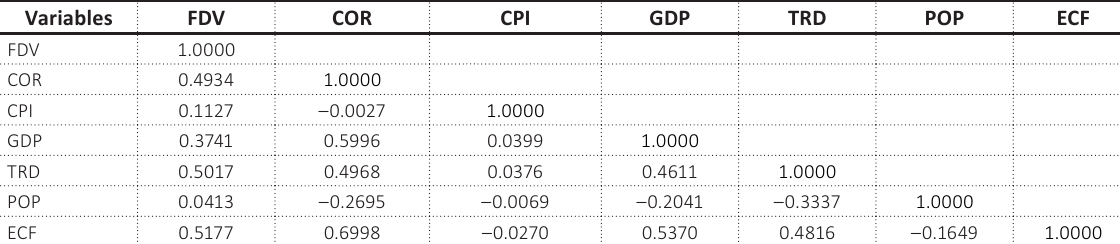
Table 2. Correlation matrix